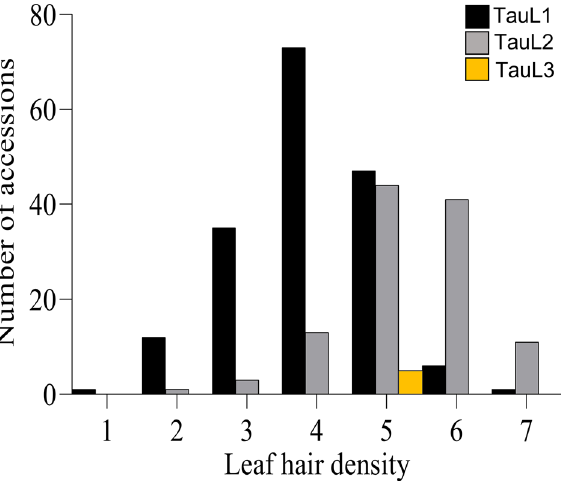
Figure 2. Leaf hair density variation in Aegilops tauschii ssp. tauschii in TauL1 (175 accessions), TauL2 (113 accessions) and TauL3 (5 accessions) lineages. Black bars represent TauL1, gray bars represent TauL2, and yellow bars represent TauL3.